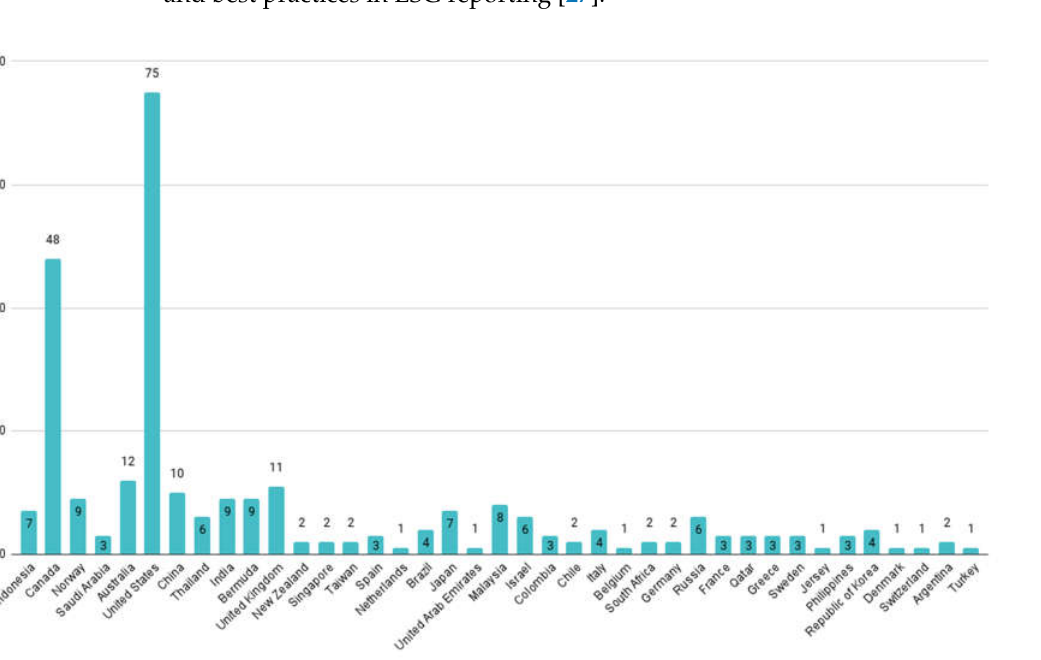
Figure 4. Count by country of energy companies. The United States, Canada, and Australia have the highest number of companies each, while Europe has the largest number of companies included in the dataset.